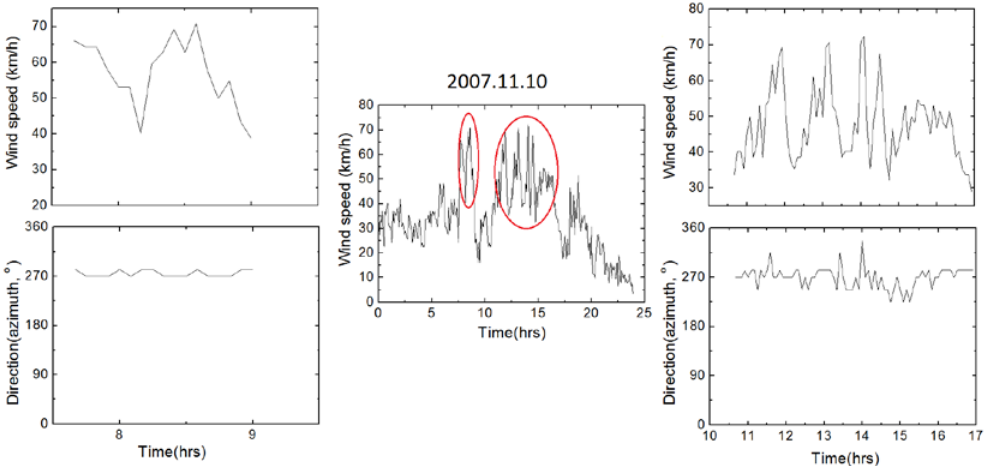
Figure 7. Details of a representative strong wind event (2007.11.10), consisting of two strong sub-events (marked by red ellipses). Details of velocity and azimuth changes are shown in the two edge columns. During the two sub-events one and five hours long, recorded wind was nearly stable in direction, ranging between approximately 30 and 70 km/h. Graph based on max winds in successive 5 min long intervals.